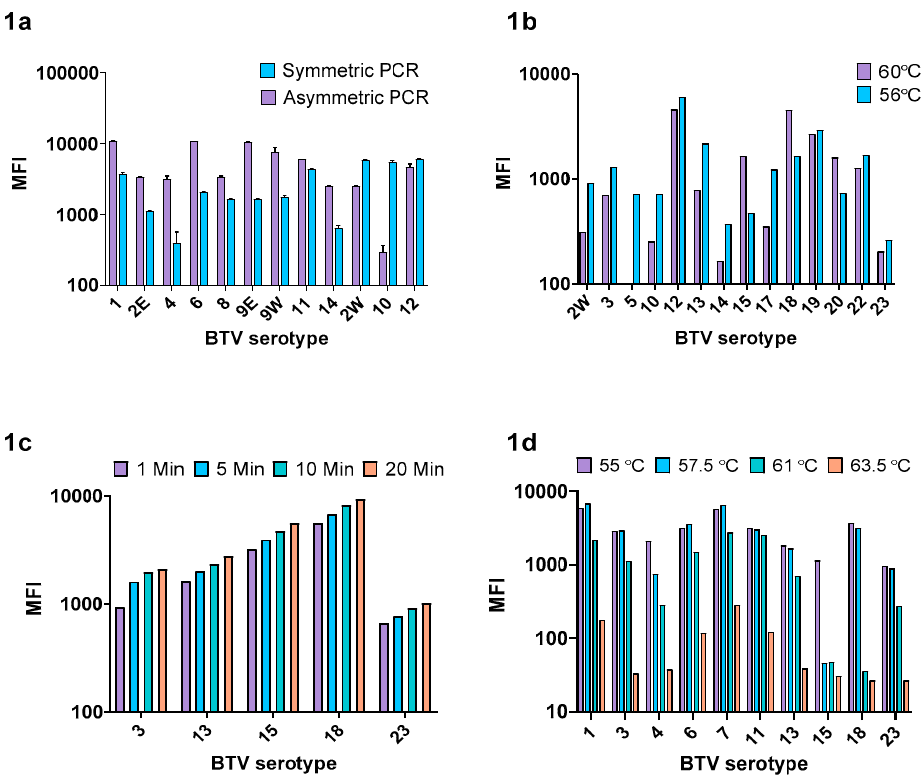
Figure 1. Bluetongue virus (BTV) xMAP assay optimization. Shown are the median fluorescence intensities (MFI) for the four stages of assay optimization: ( a ) symmetric vs. asymmetric PCR, ( b ) PCR annealing temperature, ( c ) SAPE binding duration, and ( d ) capture probe hybridization temperature.